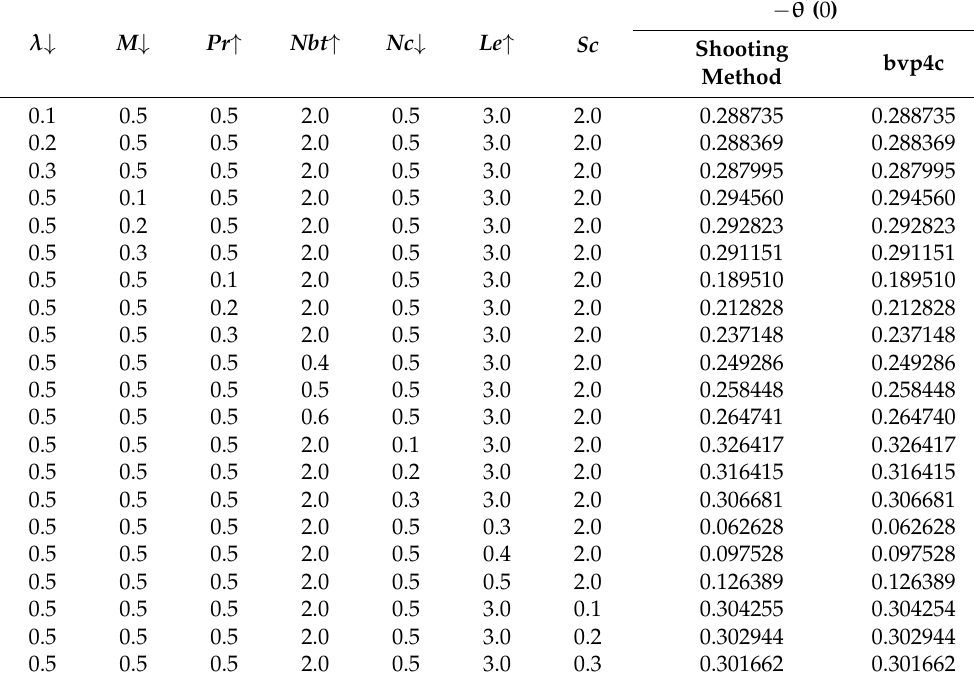
Table 2. Effect of physical parameters on Nusselt number − θ (cid:48) ( 0 )